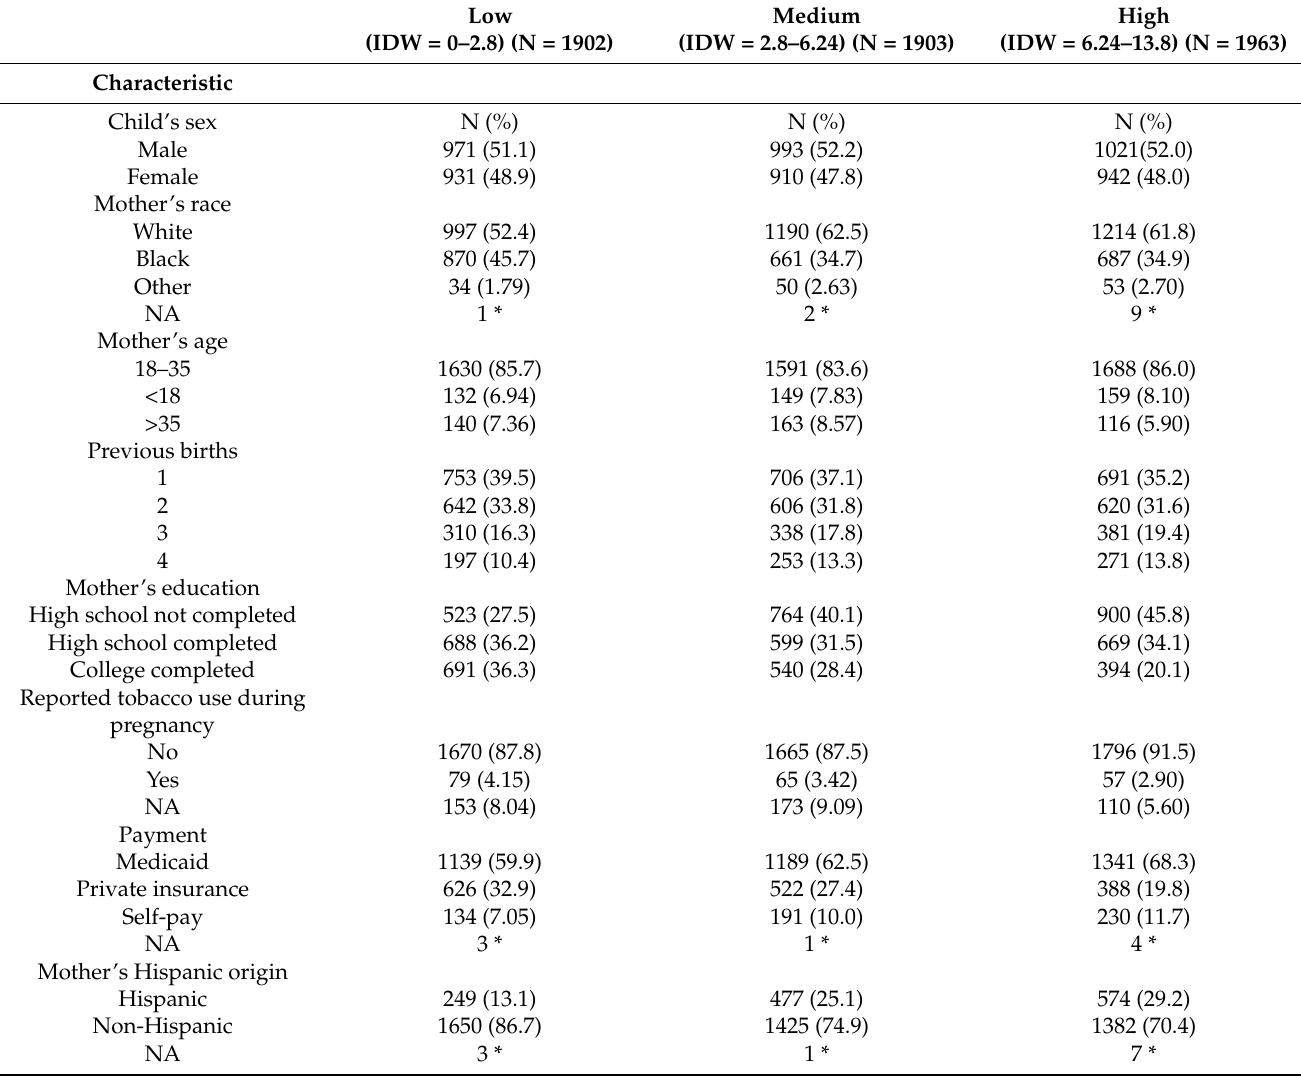
Table 1. Demographics of mother and child by low, medium, and high categories of inverse distance weighted (IDW) proximity to CAFOs *. The unit of IDW is the number of CAFOs per unit km circle. Low Medium High (IDW = 0–2.8) (N = 1902) (IDW = 2.8–6.24) (N = 1903) (IDW = 6.24–13.8) (N =